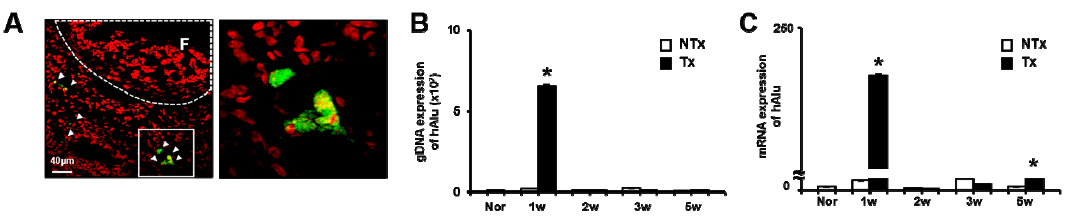
Figure 1. Placenta-derived mesenchymal stem cells (PD-MSCs) engrafted into the ovary of an ovariectomized rat model (OVX) rat model. The expression of PKH67-labeled PD-MSCs was localized in 1 week in the transplantation group (Tx) ( A ). The gDNA and mRNA expression levels of human Alu sequences in ovary tissues of the non-transplantation group (NTx) and Tx were analyzed by qRT-PCR ( B and C ). The data are representative of three independent experiments and expressed as means ± SD. * p < 0.05: NTx vs. Tx